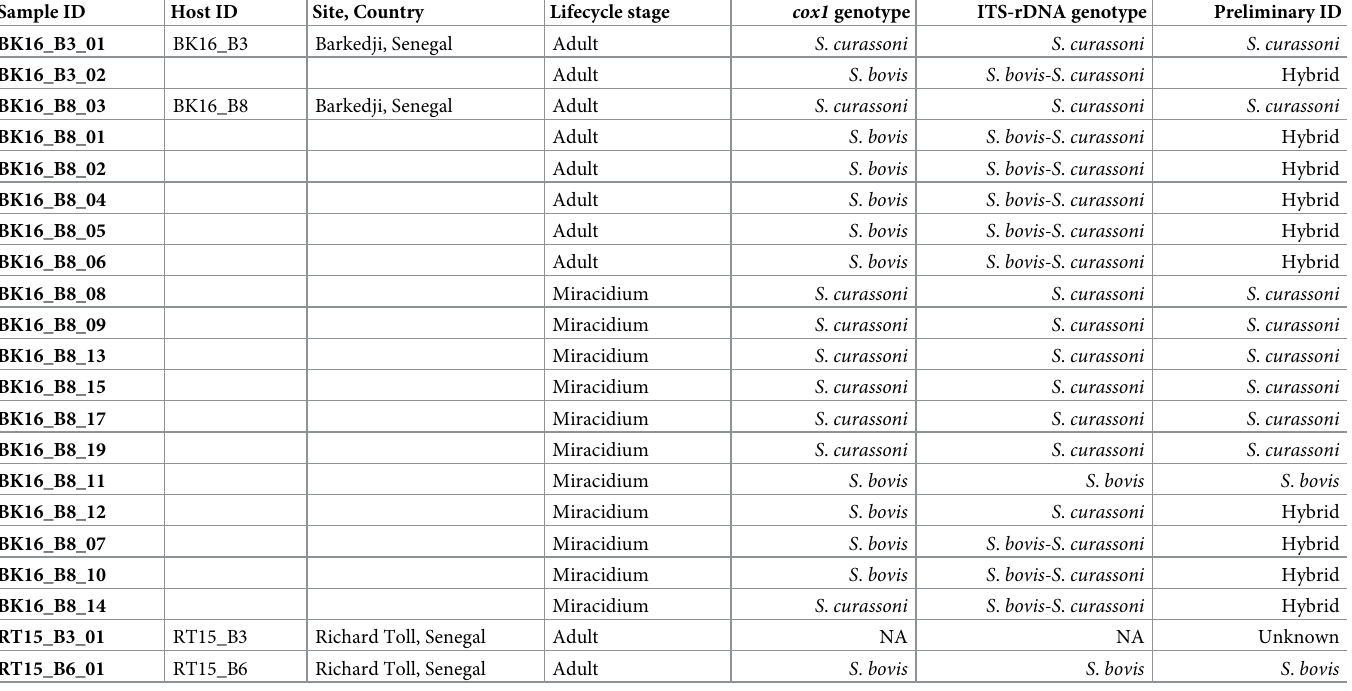
Table 2. Non-reference samples included in our analyses. Summary of field samples used for our analyses, not shown are the ‘reference samples’ (previously released are published datasets) and samples that did not pass quality control. We have also reported the results of cox1/ITS-rDNA genotyping conducted prior to sequencing. Sample ID Host